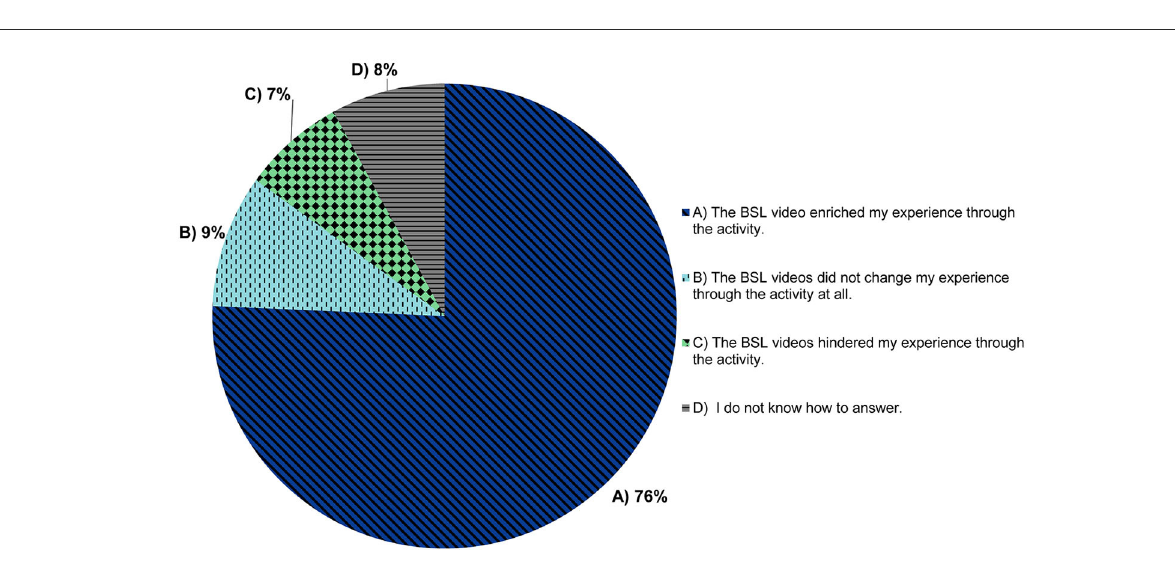
criticisms or suggestions. Therefore, 402 responses in written Portuguese were analyzed along with the 23 filmed in